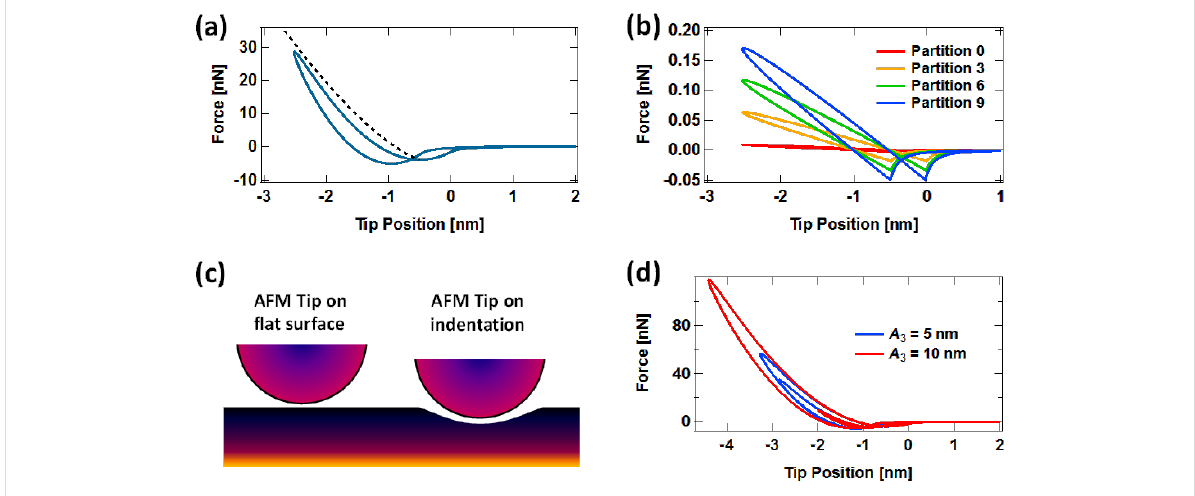
Figure 4: (a) Typical force curve for a spherical tip interacting with the Q3D surface model in monomodal tapping-mode imaging (the dashed line is a plot of a Hertzian curve, for reference); (b) illustration of the contributions to the force curve from different concentric-ring surface elements (numbered starting with the element that intersects the tip vertical axis): as the tip indents deeper into the sample, new surface elements of increasingly larger area become active and contribute to the force curve (recall that the SLS contribution of each surface element is proportional to its area); (c) schematic of the greater van der Waals interaction for a tip interacting with a cavity on the surface with respect to a tip interacting with a flat surface; (d) typical Q3D force curves for bimodal AFM imaging using the first and third eigenmodes. Note that the level of indentation increases as A 3 increases. Note also the resemblance to the force curve shown in Figure 1c. For (a), (b) and (d) the cantilever was placed at a height of 75 nm above the surface and the following parameters were used: first free oscillation amplitude A 1 = 100 nm, third free oscillation amplitude A 3 = 5 and 10 nm (as shown in (d)), fundamental frequency ν = 70 kHz, fundamental force constant k = 4 N/m, eigenmode quality factors Q 1 = 150, Q 2 = 450, Q 3 = 750; tip radius of curvature R = 20 nm, and SLS parameters (see Figure 1) k 1 = k 2 = 7.5 × 10 − 2 N/m/nm 2 , and c = 1.0 × 10 − 7 N s/m/nm 2 (monomodal AFM) and 2.5 × 10 − 8 N s/m/nm 2 (bimodal